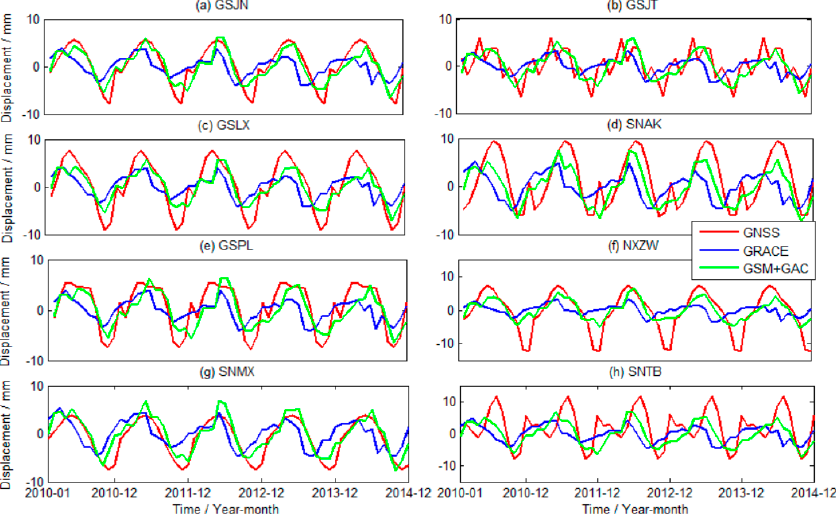
Figure 6. The crustal vertical displacement comparison with 8 CORS data and GRACE before and after GAC correction in SGN from 2010 to 2014. Table 3. Correlation coefficient and contribution rate between vertical time series from GNSS and load vertical deformation derived from GRACE in SGN from 2010 to 2014. Different GAC Correction Without GAC Correction Method